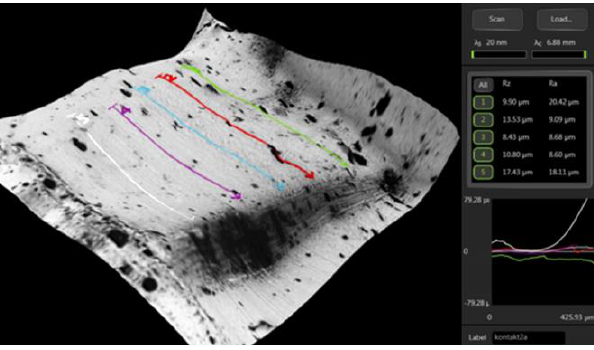
Fig. 10. Sample number 2, measurement 1 – 3D view of the test surface